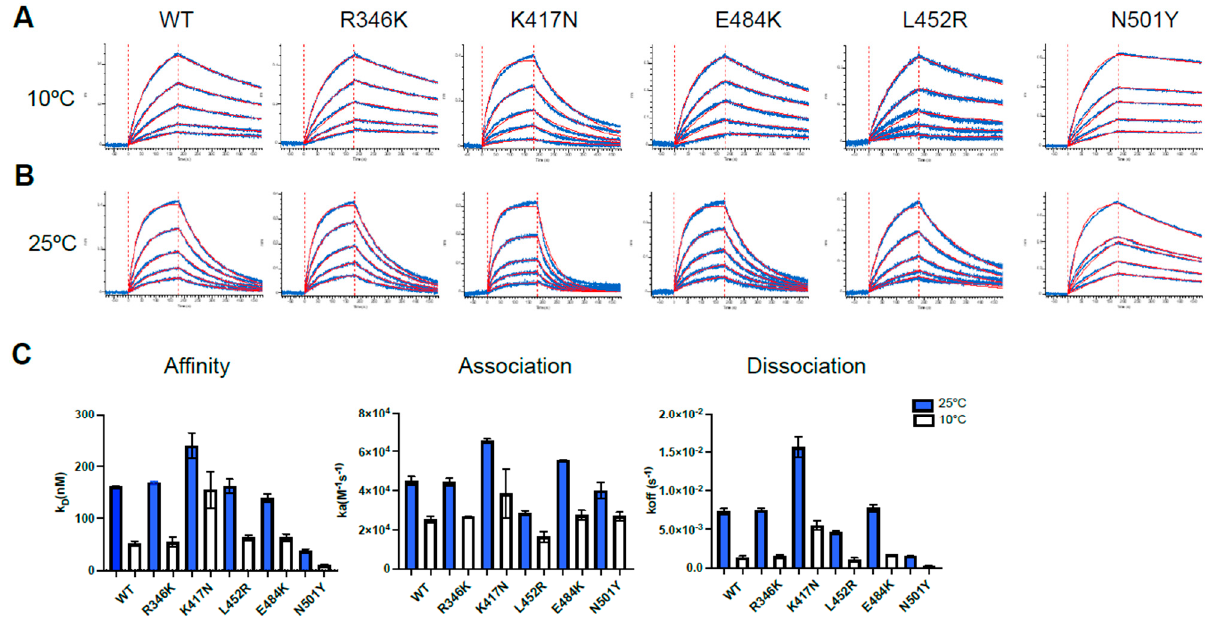
Figure 2. Analysis of hACE2-RBD binding affinity by Biolayer Interferometry . ( A – C ) Binding kinetics between SARS-CoV-2 RBD (WT or different single mutant) assessed by BLI at two different temperatures. Biosensors coated with RBD proteins were incubated in two-fold dilution series of sACE2 (500 nM–31.25 nM) at 10 °C ( A ) and 25 °C ( B ) temperatures. Representative raw data are shown in blue and fitting model is shown in red. Graphs represent the affinity constants (K D ), on rates (K a ) and off rates (K dis ), ( C ) values obtained in two different experiments at two different temperatures and calculated using a 1:1 binding model. All BLI data are summarized in Table S1.